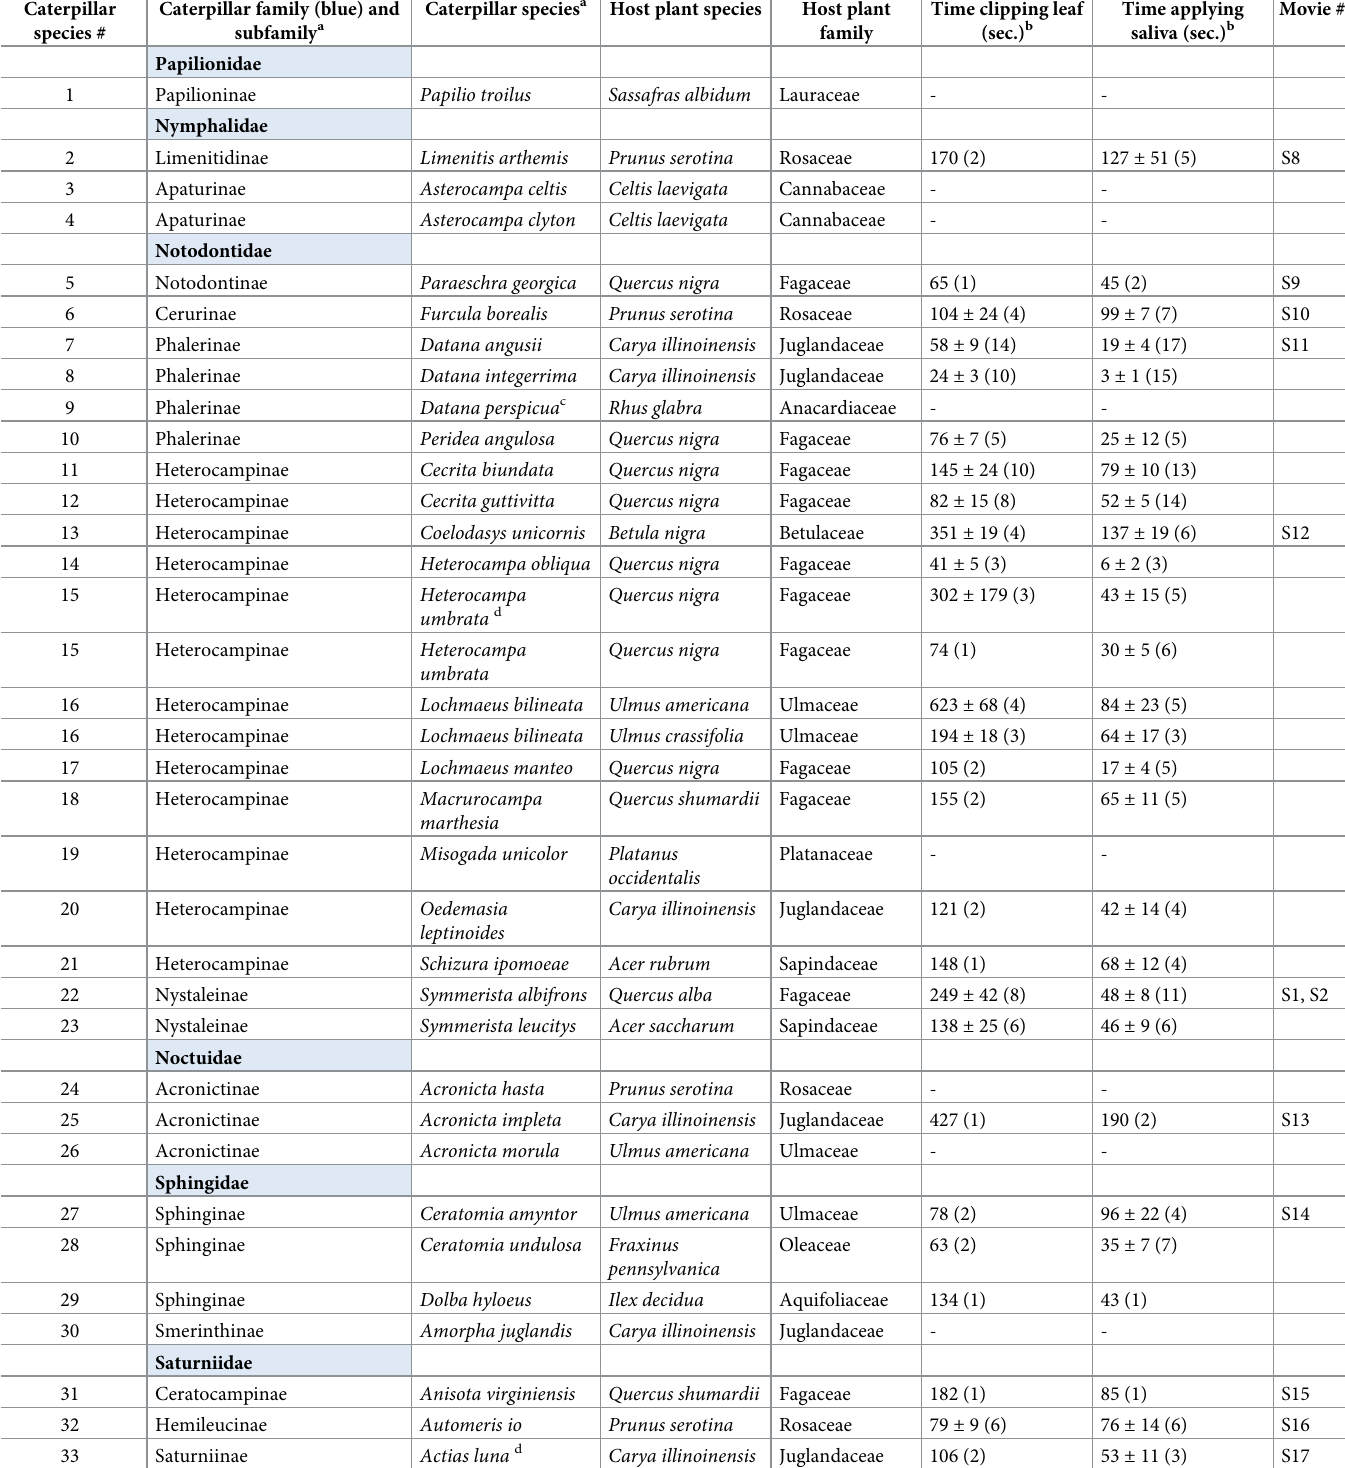
Table 1. Time that caterpillars in 34 species spent clipping leaves and applying saliva. Caterpillar species